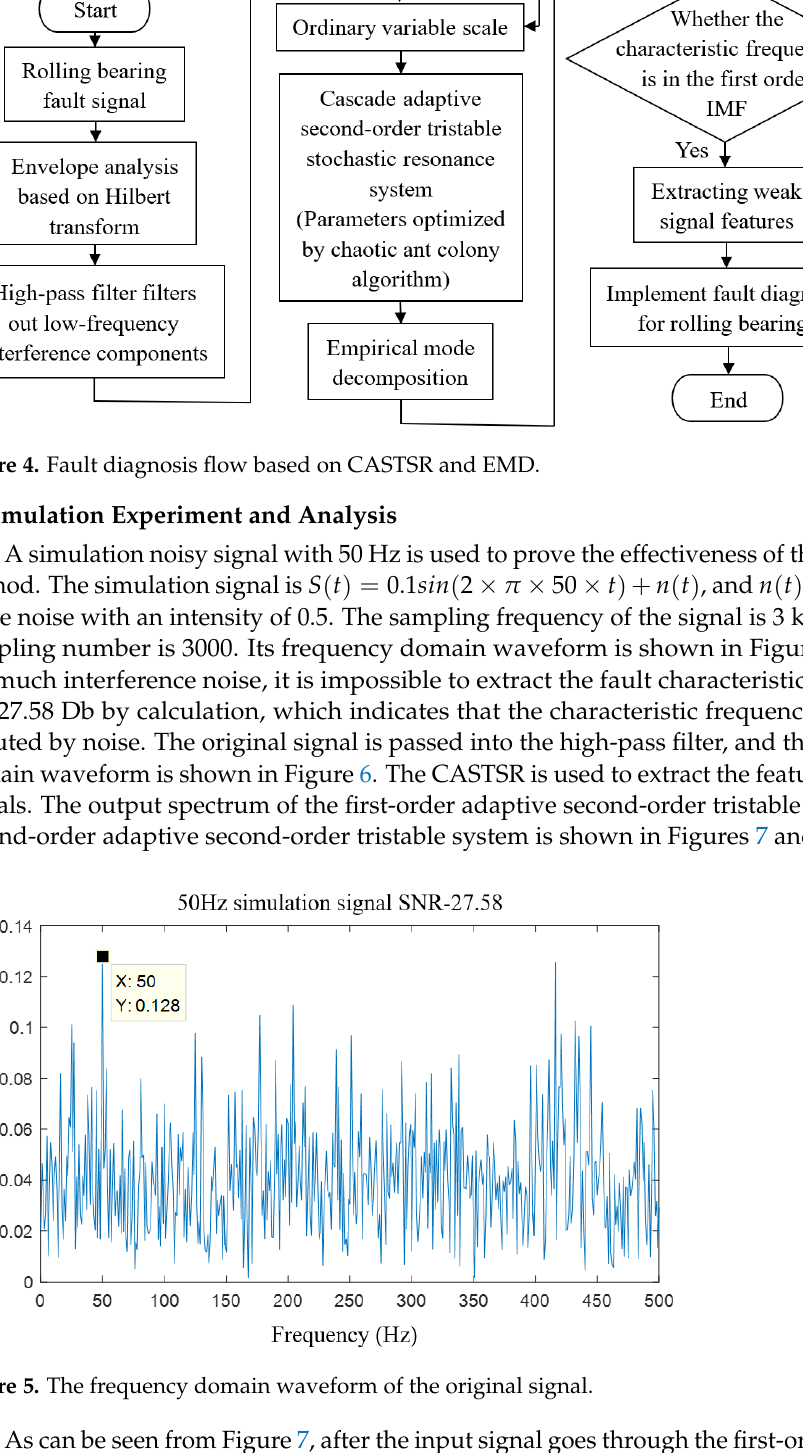
Figure 4. Fault diagnosis flow based on CASTSR and EMD.